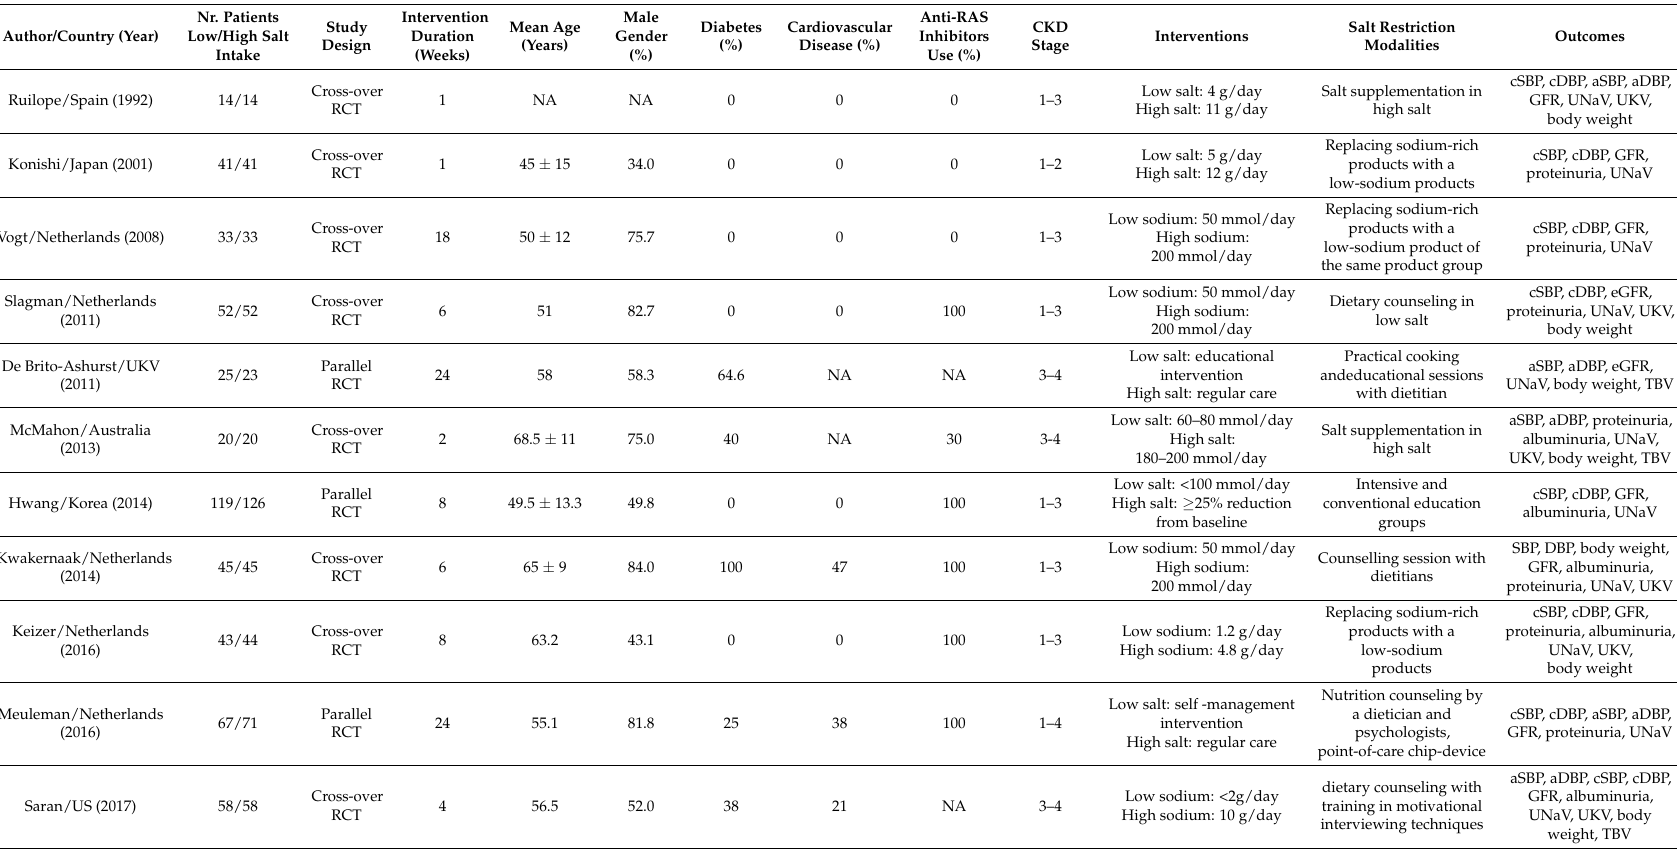
Table 1. Demographic and clinical characteristics of cohorts included in the systematic review and